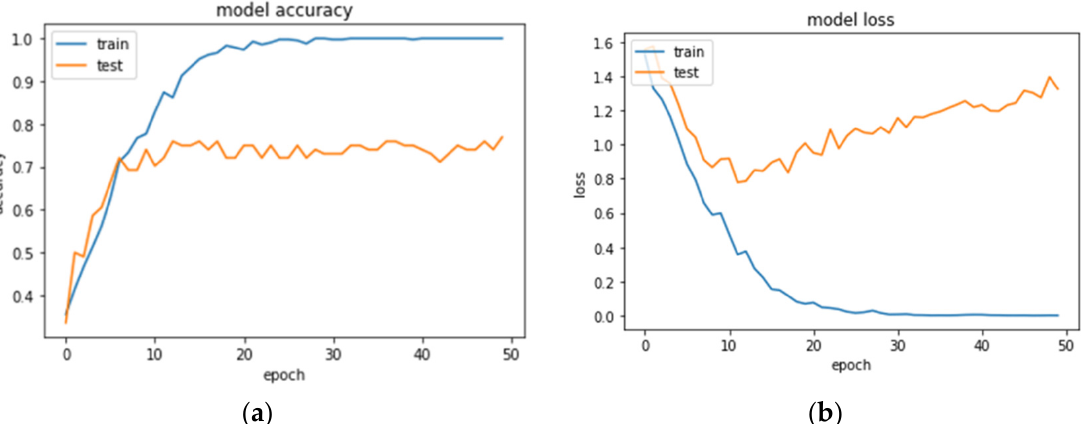
Figure 10. Training and testing of VGG16 model: ( a ) training and testing accuracy, ( b ) training and testing loss.